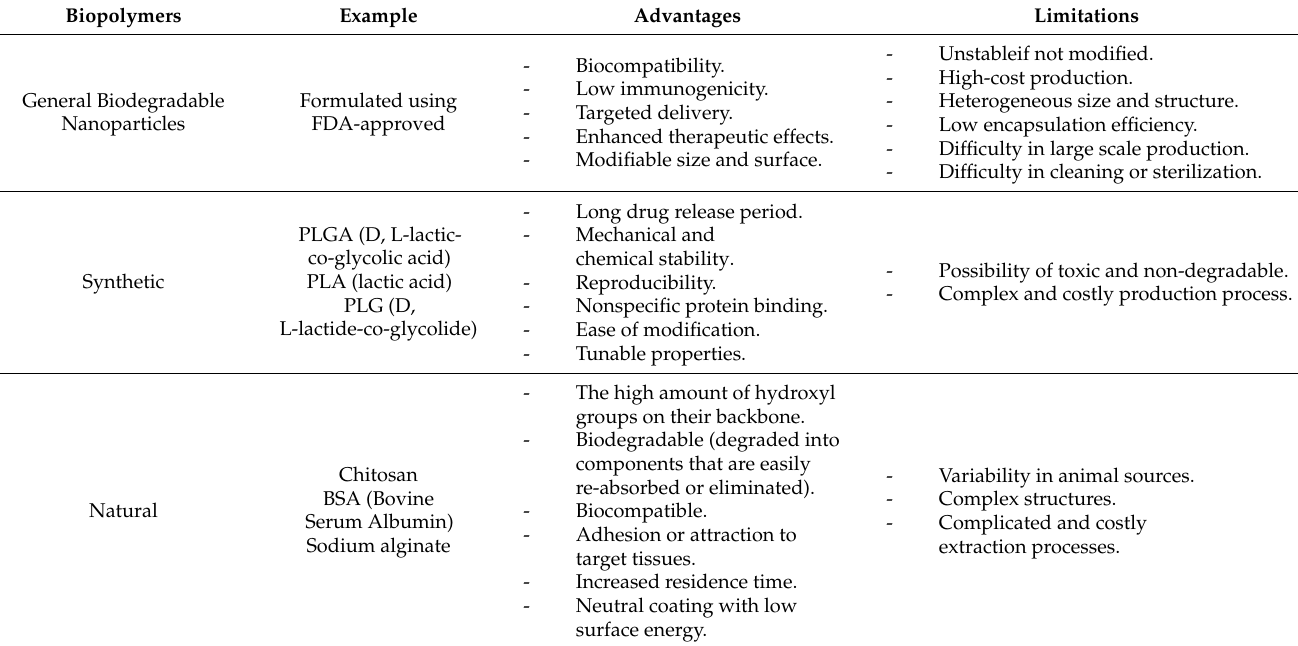
Table 3. Advantages and limitations of